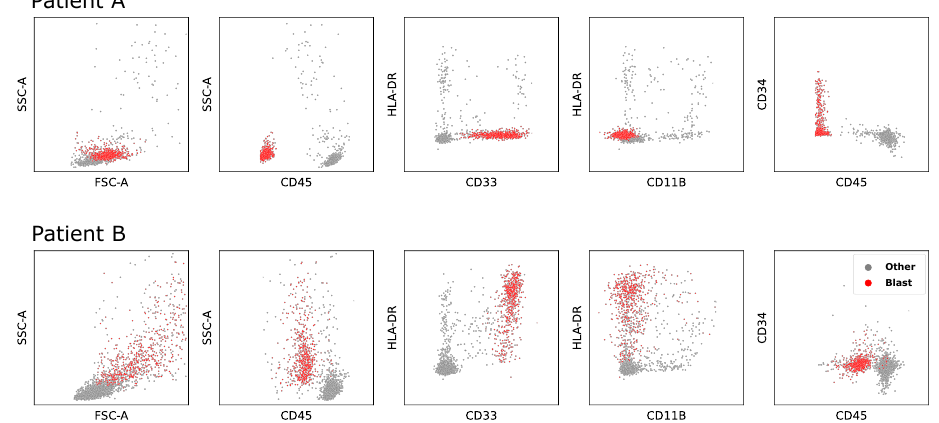
Figure 1. FCM-MRD data of two different patients. FCM data are typically visualized for manual gating by multiple 2D plots with different parameters as axis. Each dot represents the measurement vector of a single cell measured with a flow cytometer. Red dots denote leukemic cells and grey dots healthy cell populations. The Cluster of Differentiation (e.g., CD45) indicate antigens while SSC-A and FSC-A display the cell’s side and forward scatter. Note that the blast population varies in location and density between the different